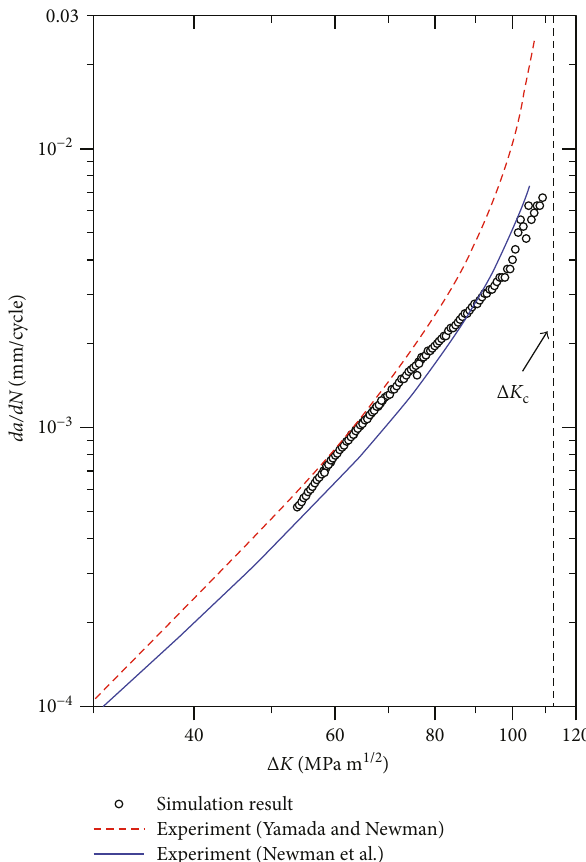
Figure 13: Comparison between experiments and the proposed CCZM under the constant force amplitude with R = 0 1